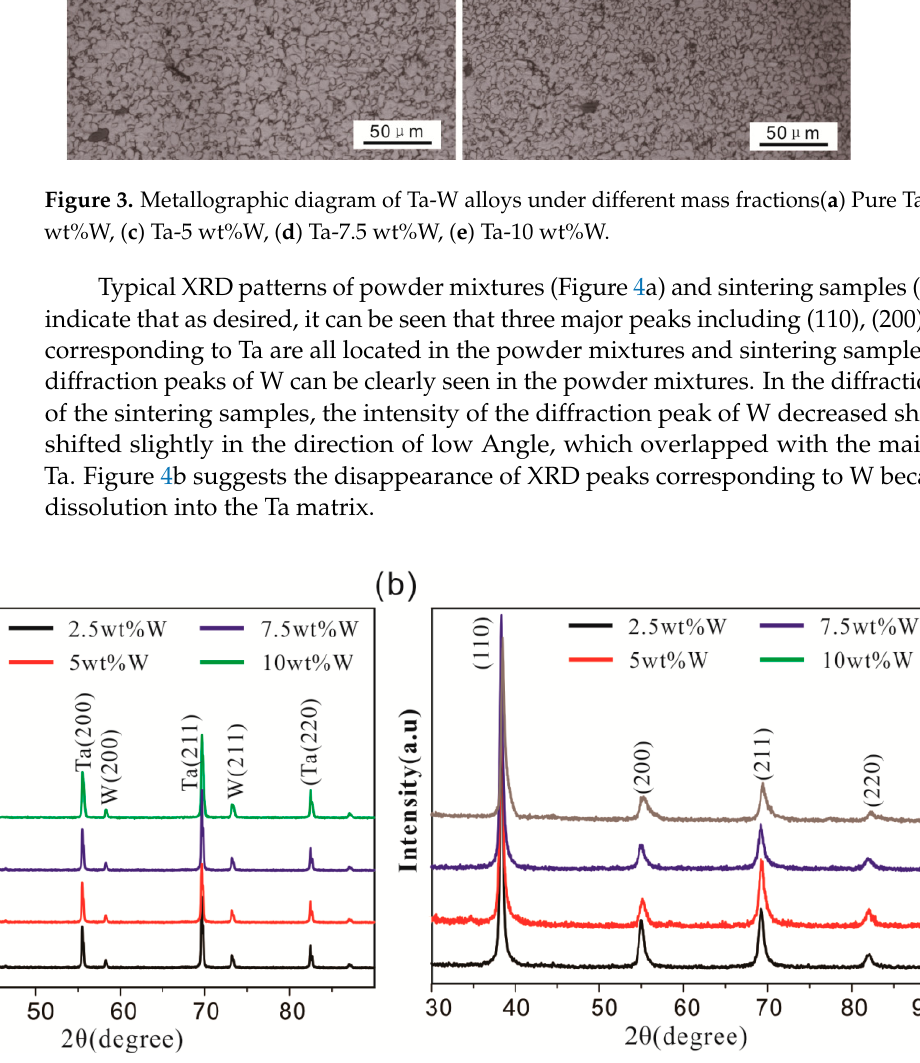
Table 2. Theoretical and measured values of lattice constants of tantalum tungsten alloy.